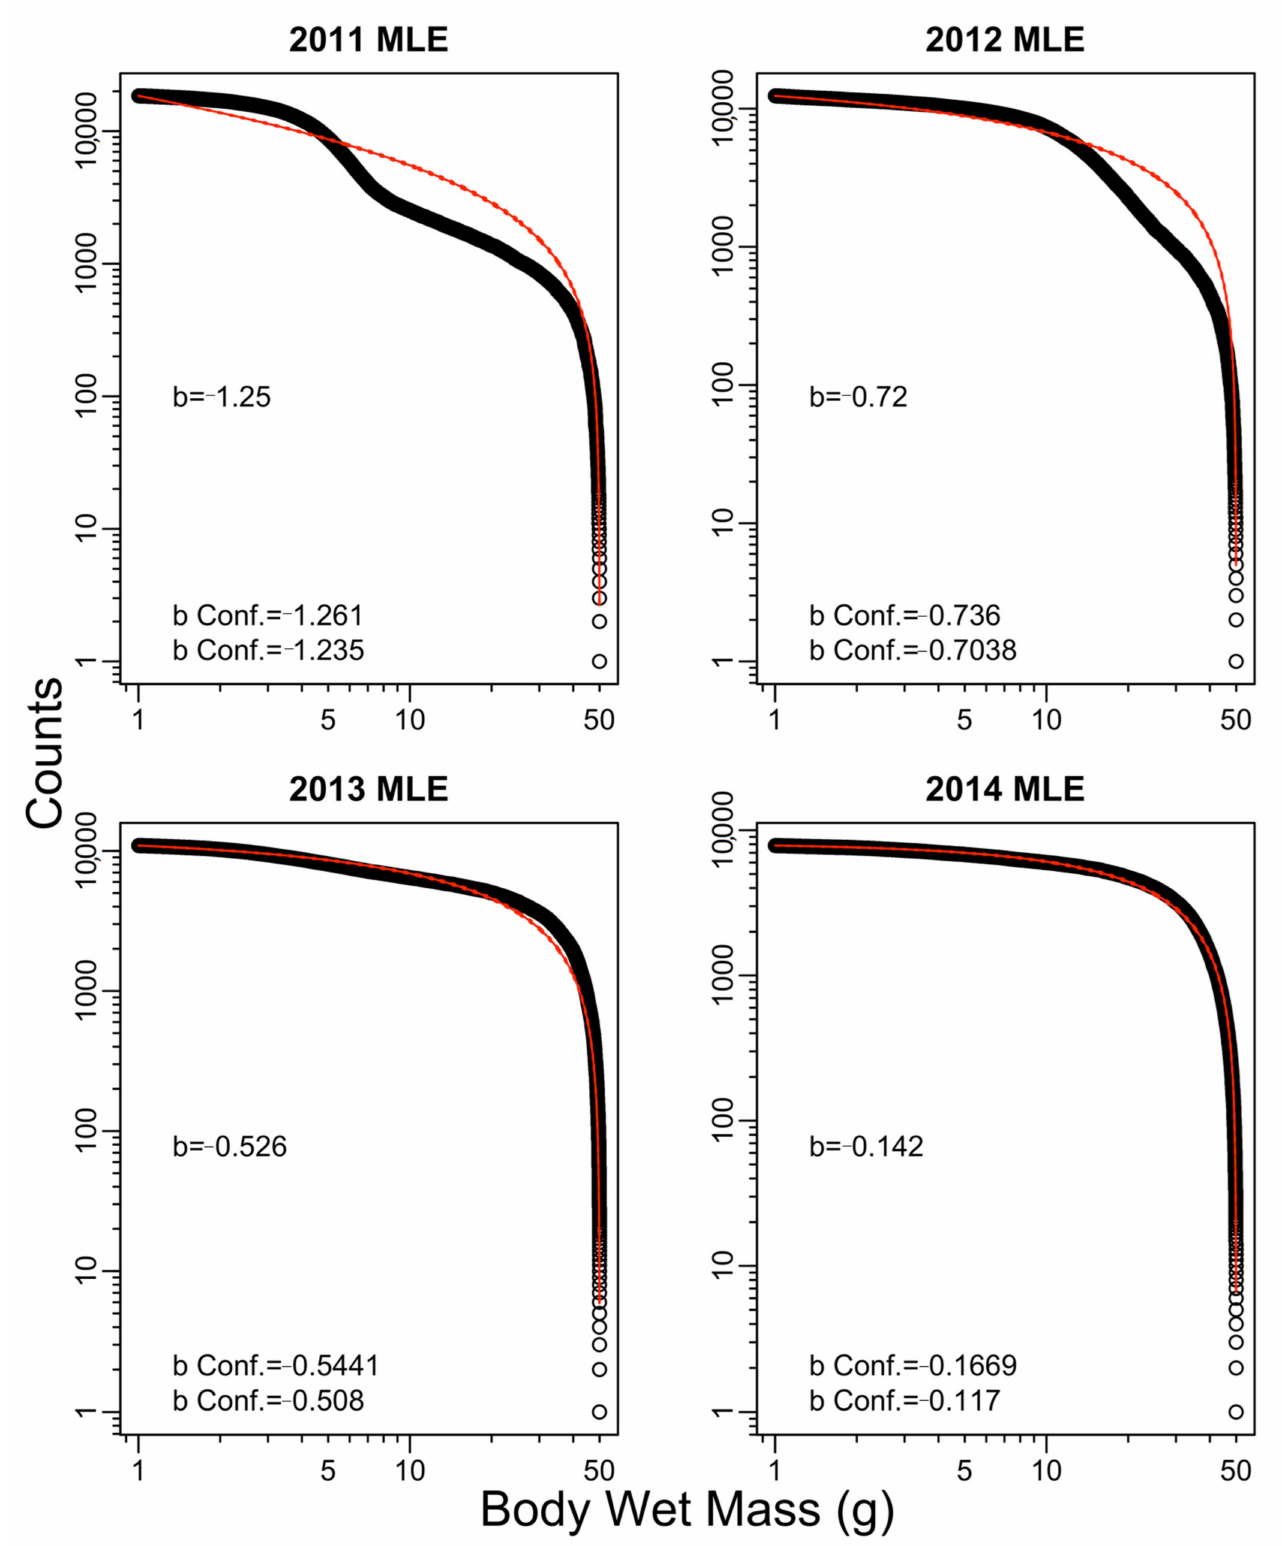
Figure A5. Fish SS with counts and body wet mass (g) fitted using the maximum likelihood estimate of exponent b with the 95% confidence interval of b based on SEDs from hydroacoustic surveys for